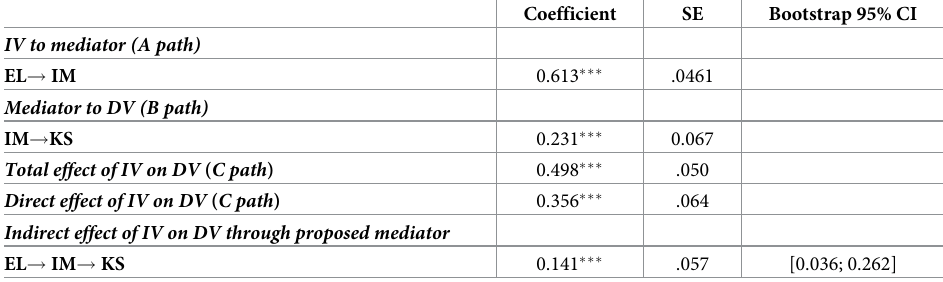
Table 4. Results of the mediation analyses of EL, IM, and KS (without